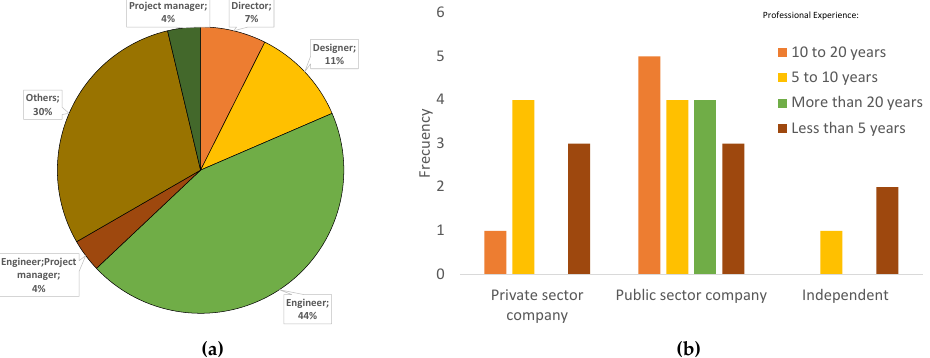
Figure 11. Professionals surveyed: ( a ) by job position and ( b ) by job sector according to years of experience.